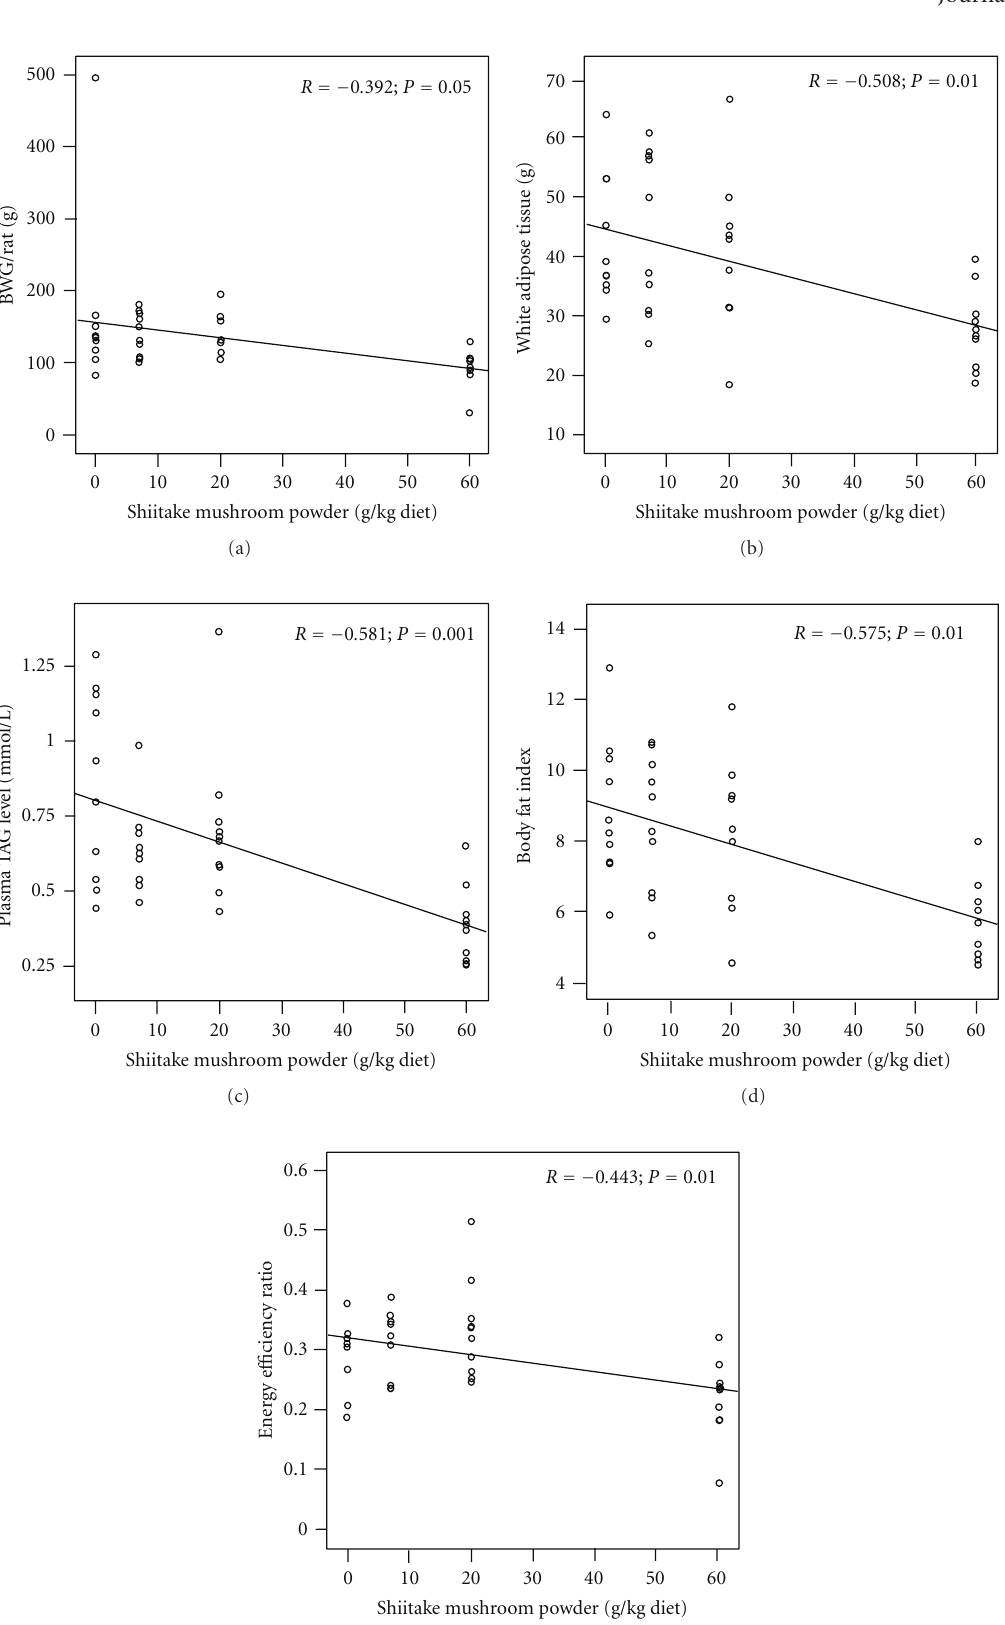
Figure 5: Significant correlations were found between dosages and BWG (a), WAT (b), plasma TAG level (c), BFI (d), and (e) EER. BWG: body weight gain; WAT: white adipose tissue; TAG: triacylglycerol; BFI: body fat index; EER: energy e ffi ciency